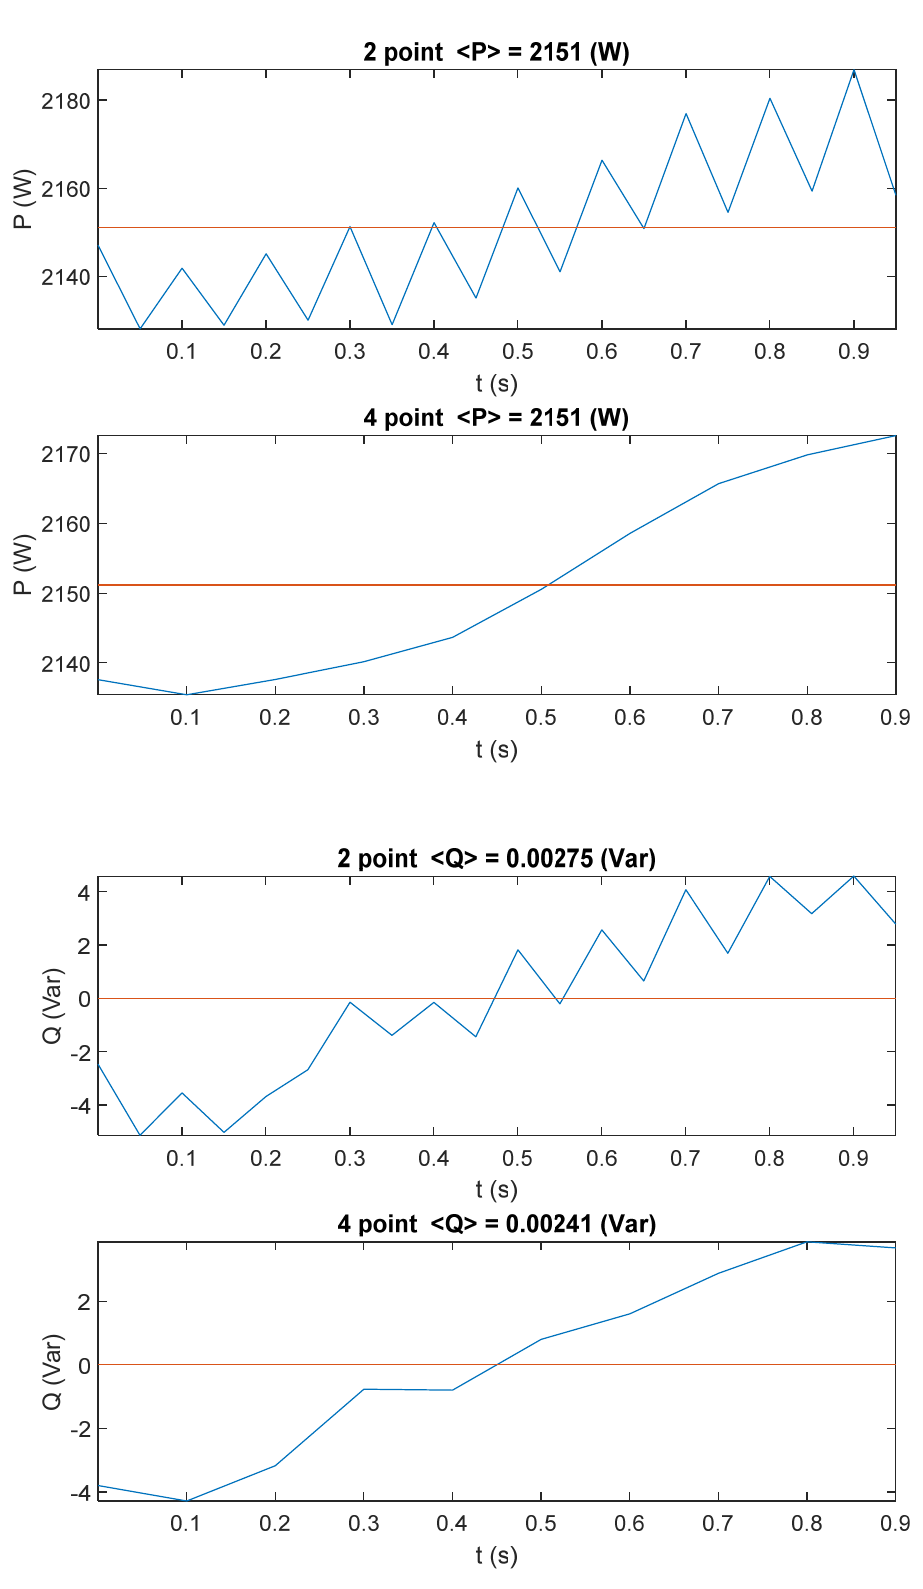
Figure 8. Two-point vs. four-point measurement method of power (after correction).